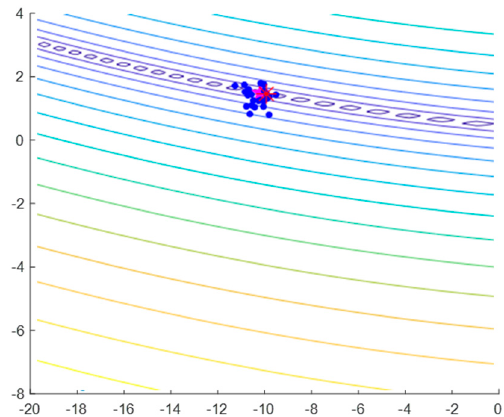
Figure 3. The beta distribution of the population after a few iterations.